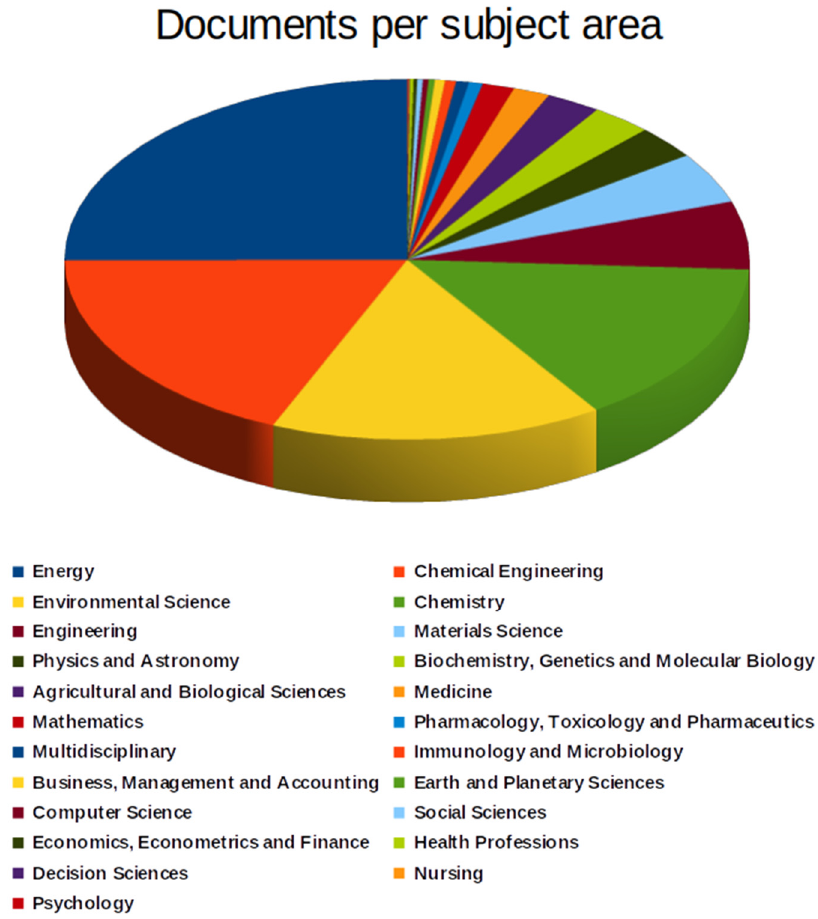
Figure 3. Documents per subject area.